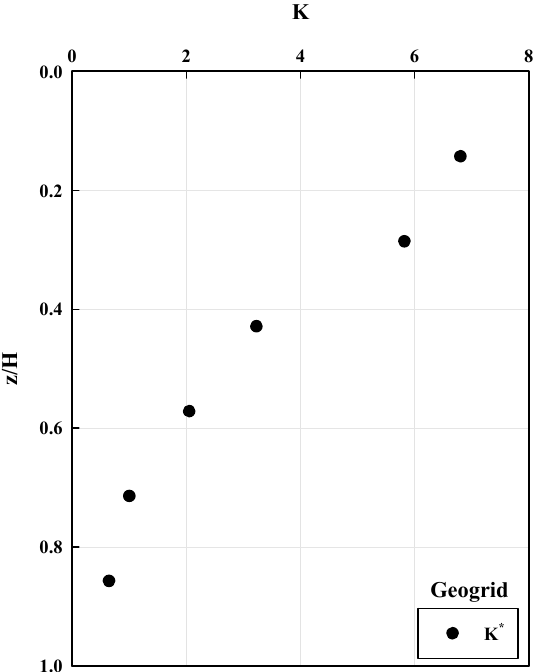
Figure 14. Variation of K * along the abutment after 120 cycles.